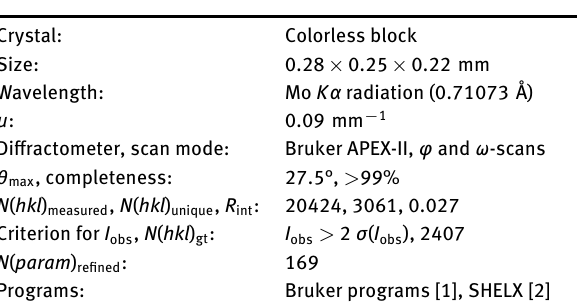
Table 1: Data collection and handling.